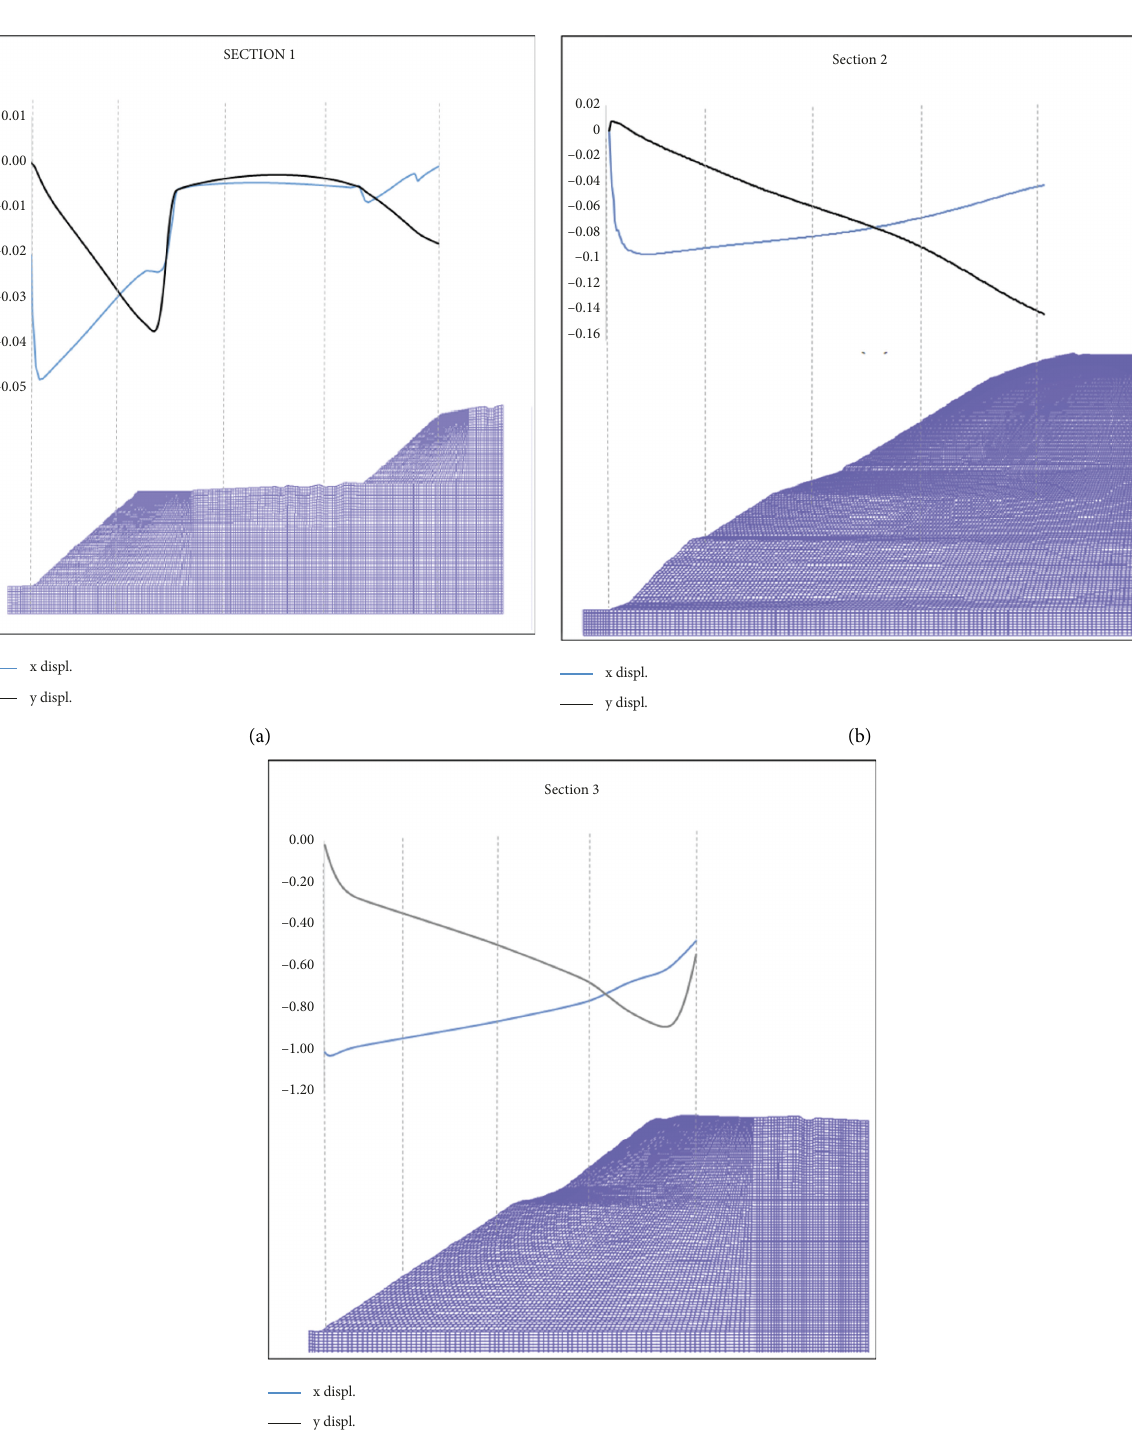
Figure 16: (a–c) represent the displacement profile in meters. The plotted displacement of the X and Y axes along the surface of the geometries of sections 1, 2, and 3 from toe to the pick of the